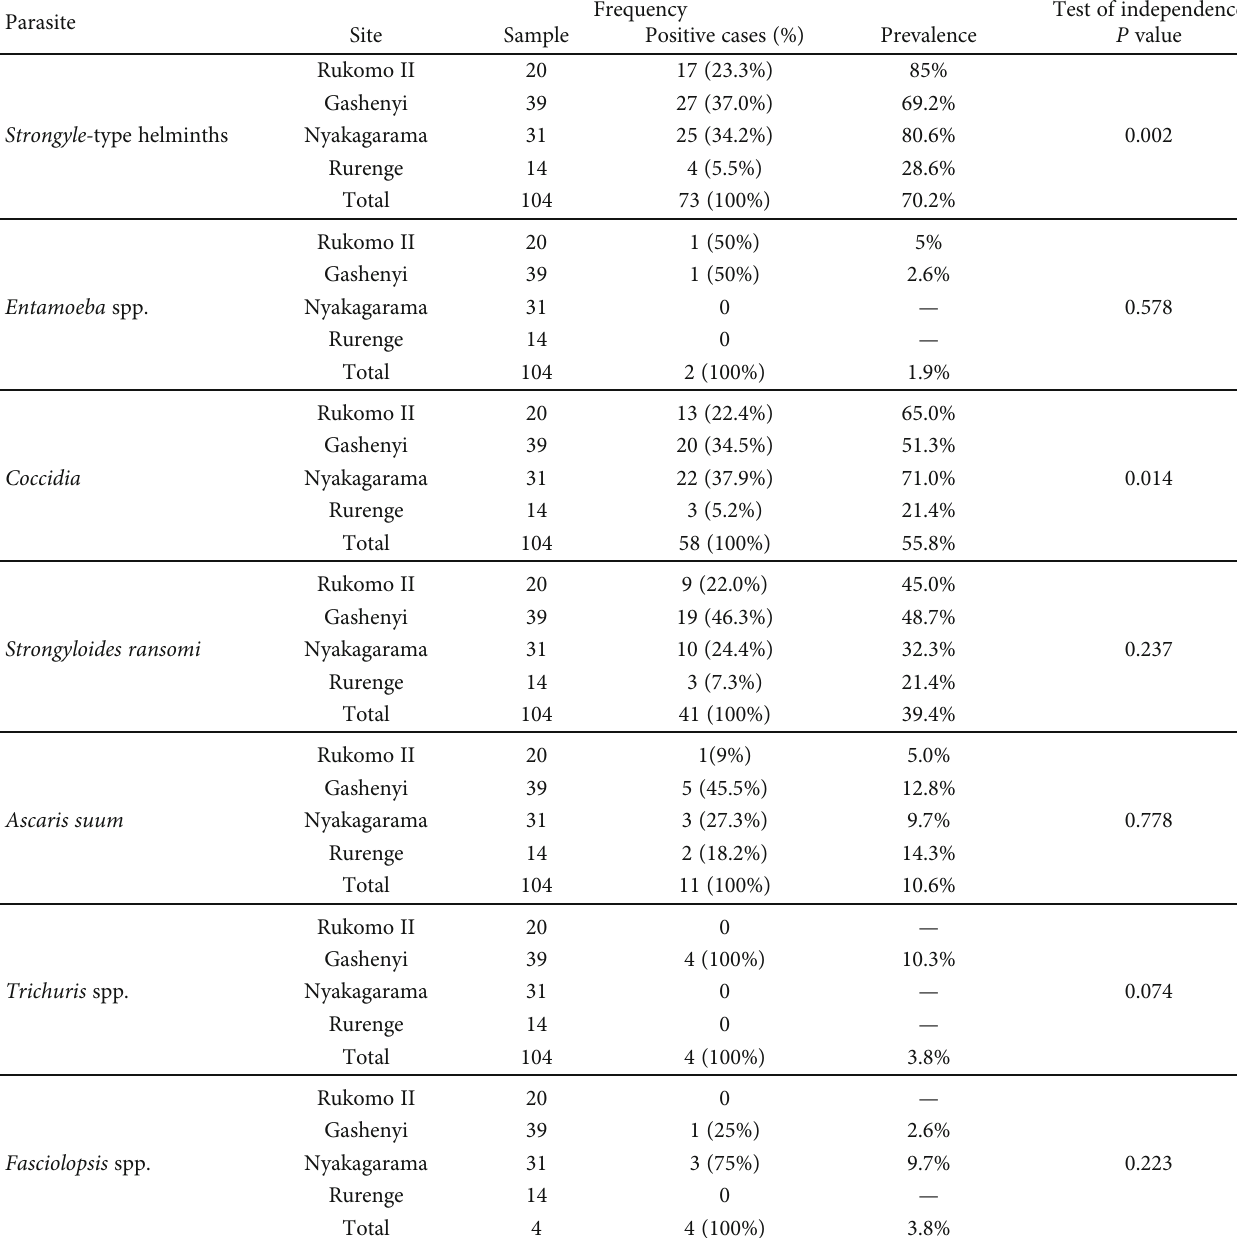
Table 2: Prevalence and test of association of gastrointestinal parasites with study locations ( n = 104 ).